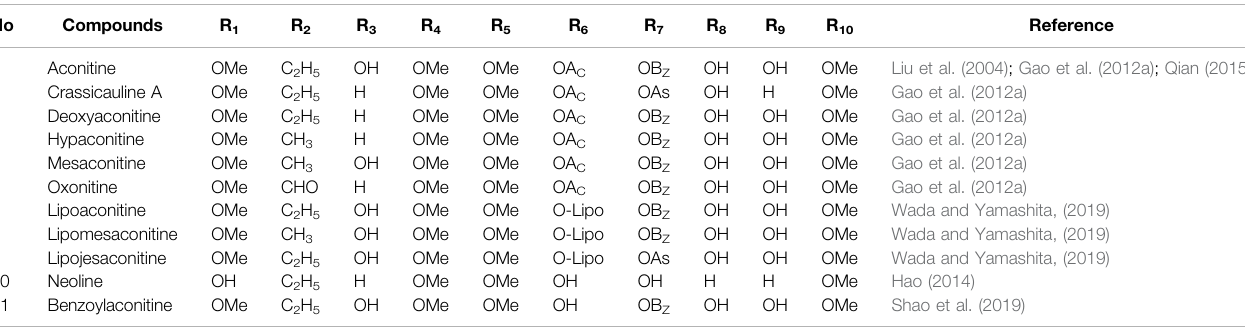
TABLE 1 | Structures of natural C 19 diterpenoid alkaloids with anticancer activities in